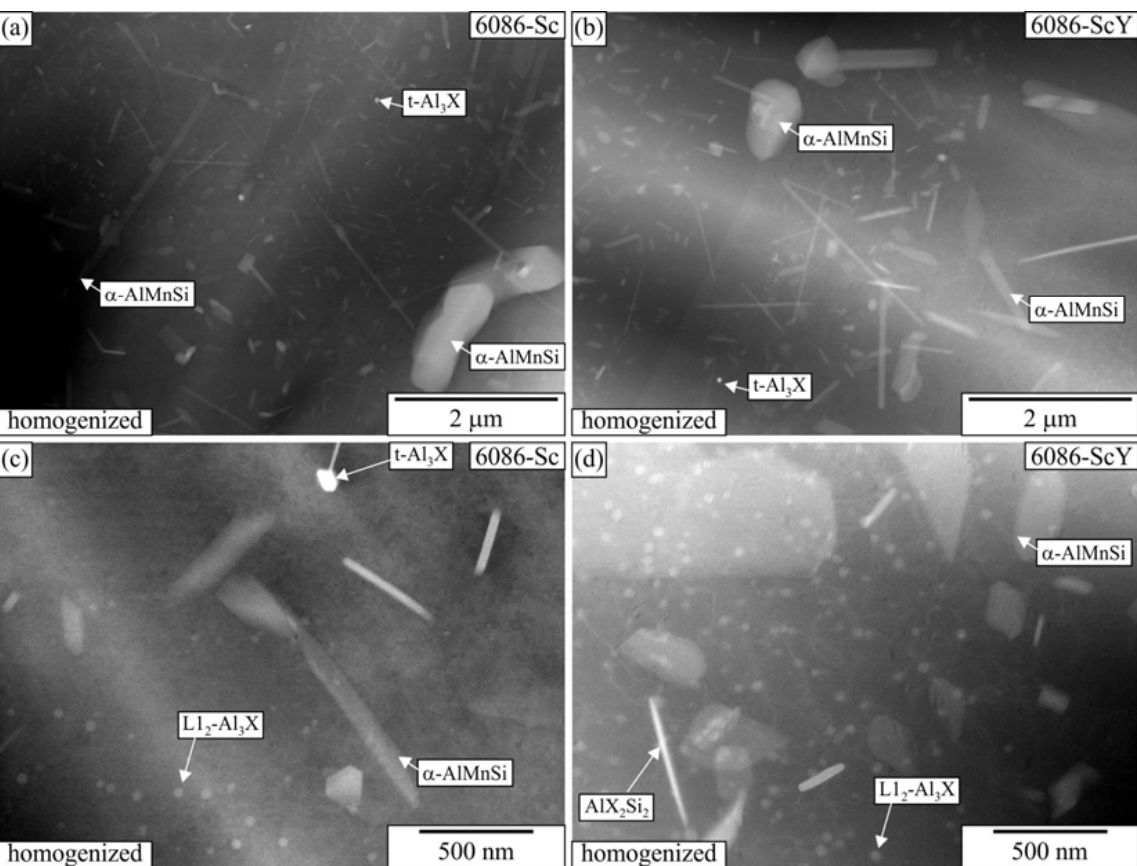
Figure 6. HAADF-TEM micrographs of the sample 6086–Sc and 6086_ScY after homogenization (520 °C, 6 h). A larger area at a grain boundary ( a ) 6086-Sc, ( b ) 6086-ScY. An area at the dendrite centre, ( c ) 6086-Sc, and ( d ) 6086-ScY.